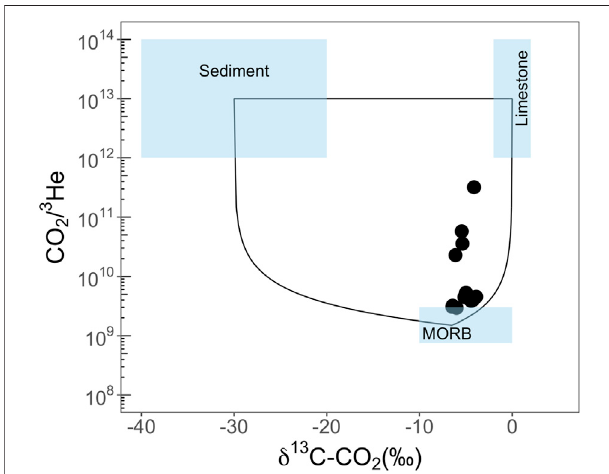
FIGURE 5 | A plot of CO 2 / 3 He vs. δ 13 C(CO 2 ). The endmember compositions are δ 13 C = − 6.5 ‰ for mantle (M), 0 ‰ for limestone (L), and − 30 ‰ for sediment (S) (relative to VPDB), and CO 10 13 for L and S, respectively (Sano and Marty, 1995). A 3-component mixing model between M – L – S can explain all data in the Rungwe Volcanic Province (Barry et al., 2013).